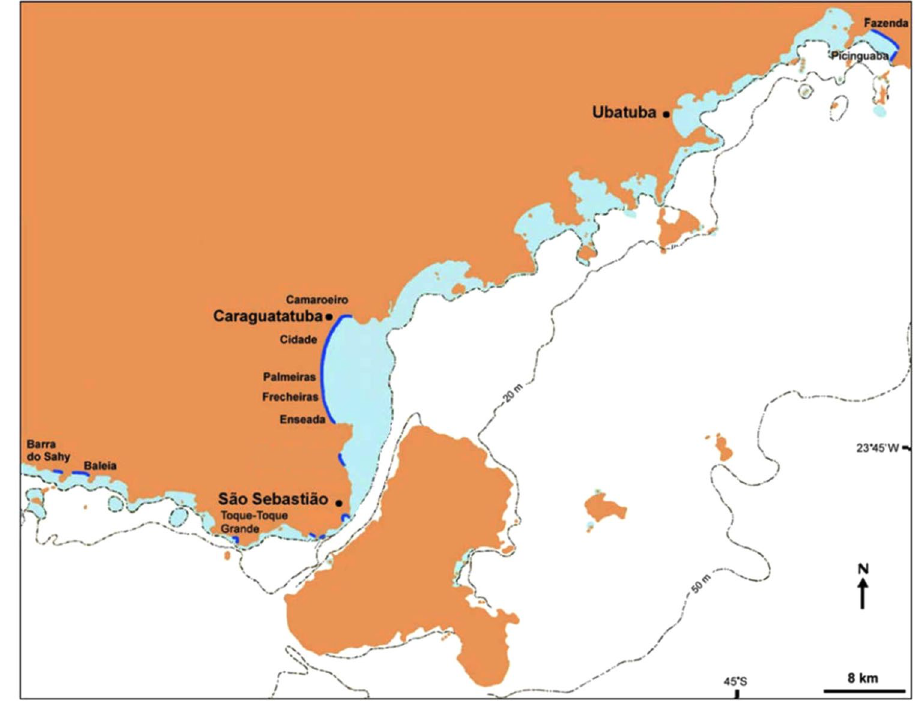
Sampled beaches: Barra do Sahy (23°46 ′ 30 ″ S, 45°41 ′ 40 ″ W), Baleia (23°46 ′ 28 ″ S, 45°40 ′ 31 ″ W),